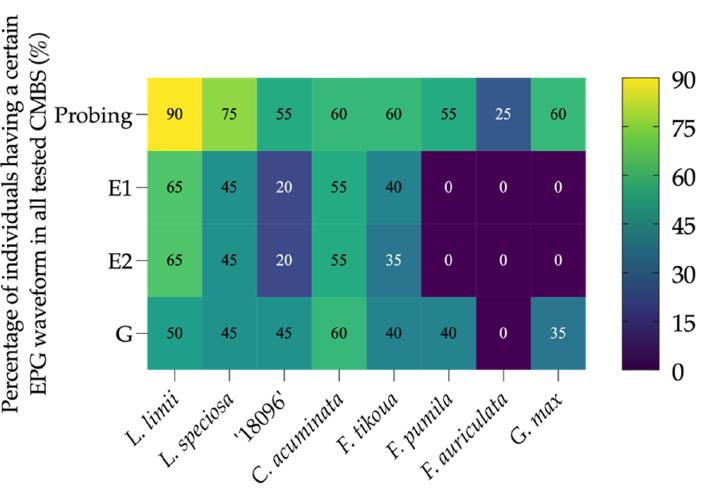
Figure 2. Percentage of individuals having a certain EPG waveform in all tested Acanthococcus lager- stroemiae samples among eight plant species.